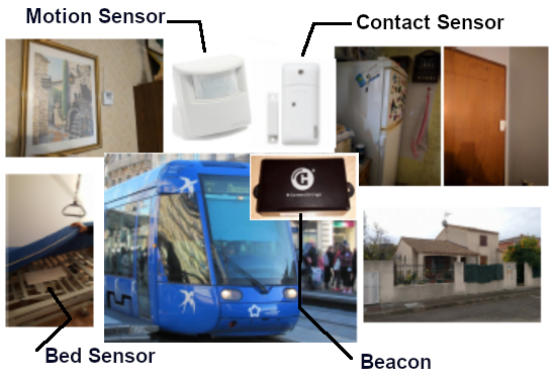
Figure 3. Indoor and outdoor sensors’ deployment.